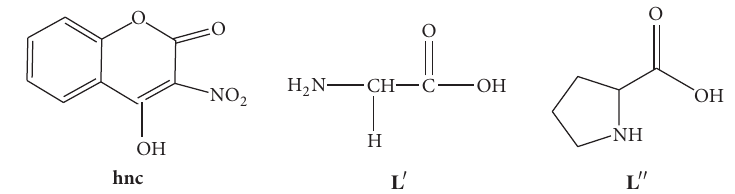
Figure 1: Structures of the